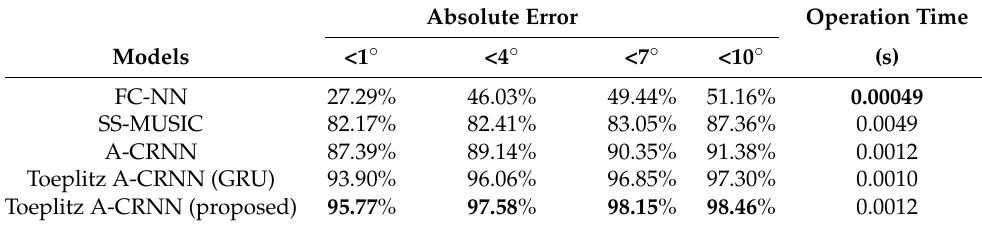
Table 3. Accuracies of three-source coherent DOA estimation at the SNR of 20